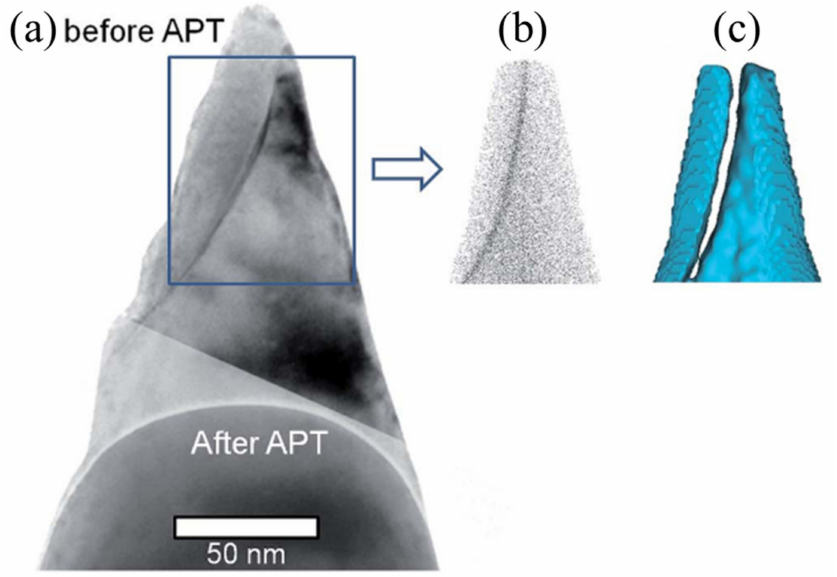
Figure 4. ( a ) Overlay of transmission electron microscope images of an atom probe NDC10 specimen before and after atom probe analysis. A GB is observed in the before image. The after image indicates that the atom probe analysis encompassed the entire GB region. Atom probe data reconstructions showing ( b ) Nd, and ( c ) a 66 at% oxygen iso-concentration surface [79]. Reproduced from [79] with permission from The Royal Society of